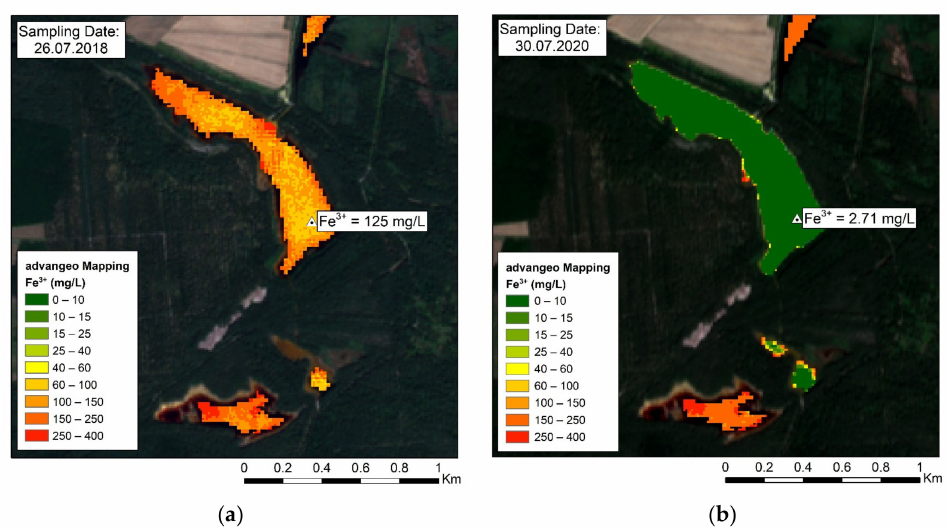
Figure 16. Distribution map of Fe 3+ in the “Grüner See” ( a ) in July 2018 with AMD and ( b ) in July 2020 after the neutralization of the acid mine